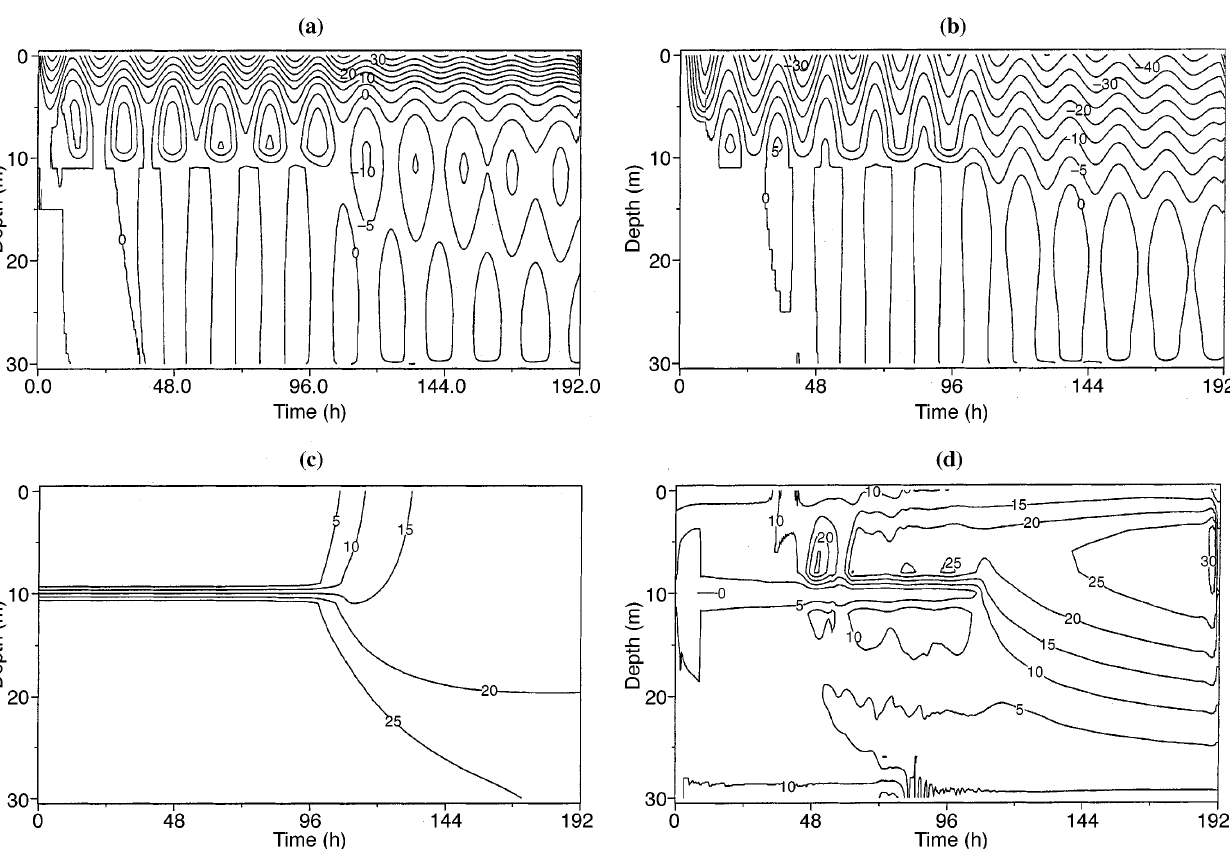
Fig. 4a–d. Optimal solution and optimal turbulent viscosity obtained by the assimilation of the salinity data. a Velocity u (cid:133) cm (cid:1) s (cid:255) 1 (cid:134) , b velocity v (cid:133) cm (cid:1) s (cid:255) 1 (cid:134) , c salinity (psu), d turbulent viscosity (cid:133) cm 2 (cid:1) s (cid:255) 1 (cid:134) . The contour intervals are 5 units for each variable